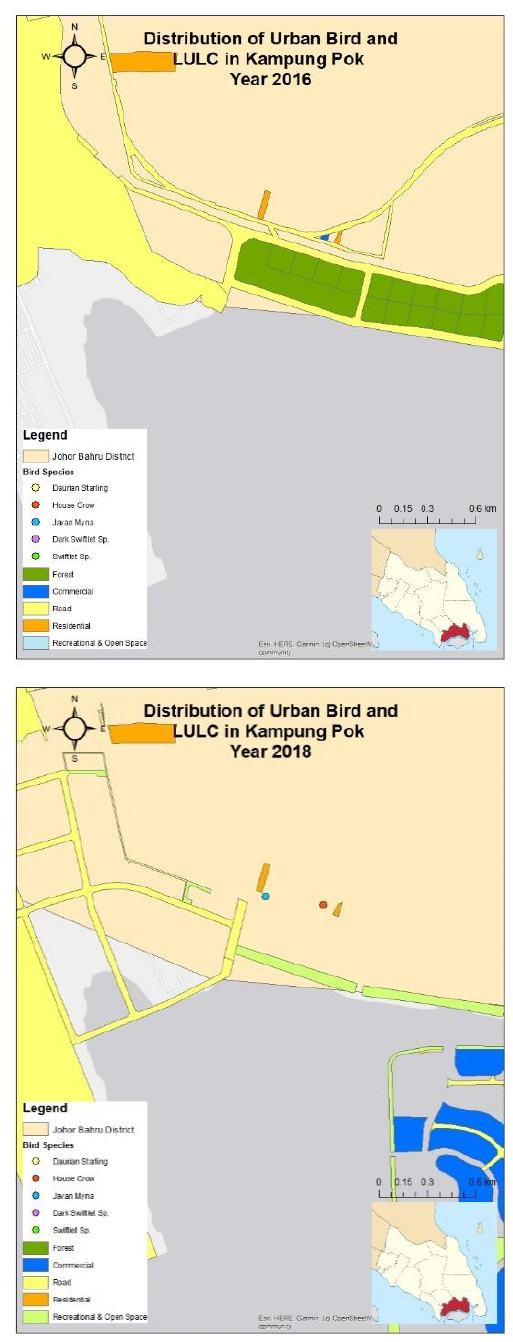
Figure 6 Bird distribution over land cover map in Kampung